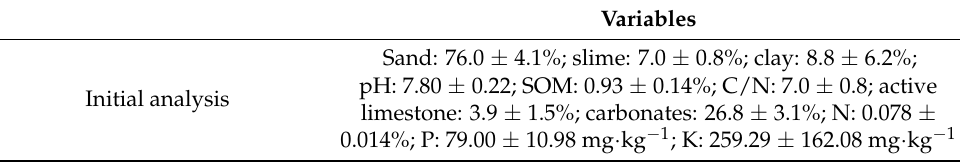
Table 1. Physical and chemical composition of greenhouse soil.